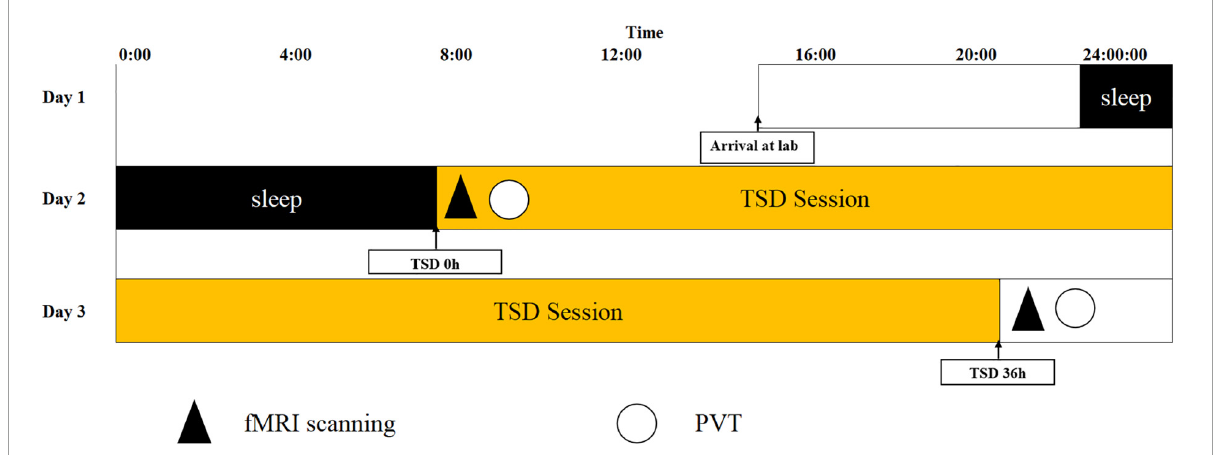
FIGURE2 Experimental flow chart. Total sleep deprivation (TSD) began after a routine nocturnal sleep period, at 08:00 on Day 2, and ended at 20:00 at Day 3. Participants were required to stay awake for 36 h during the whole TSD session. Participants performed psychomotor vigilance tasks (PVT) and functional magnetic resonance imaging (fMRI) scanning at 20:00 on Day 2. After 36 h TSD, fMRI scanning, and PVT was performed at approximately 20:00 on Day 3 for all